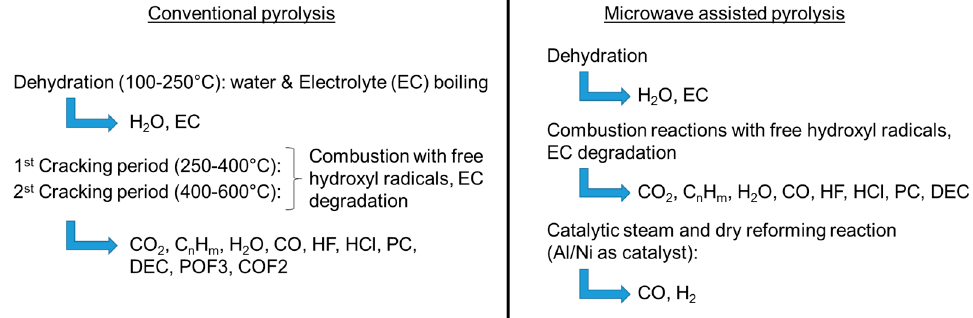
Figure 13. Basic degradation of organics present in commercial cathodes from LIBs during conventional and microwave assisted pyrolysis.